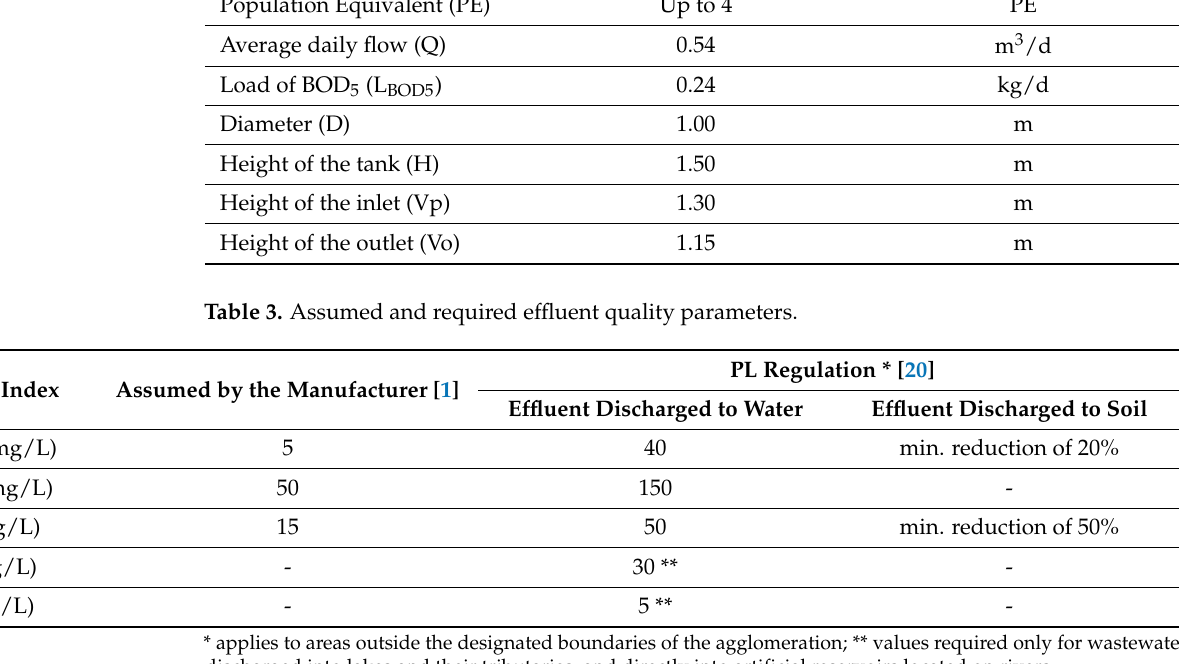
Table 2. Technical parameters of container on-site wastewater treatment plant with low-loaded activated sludge [19].